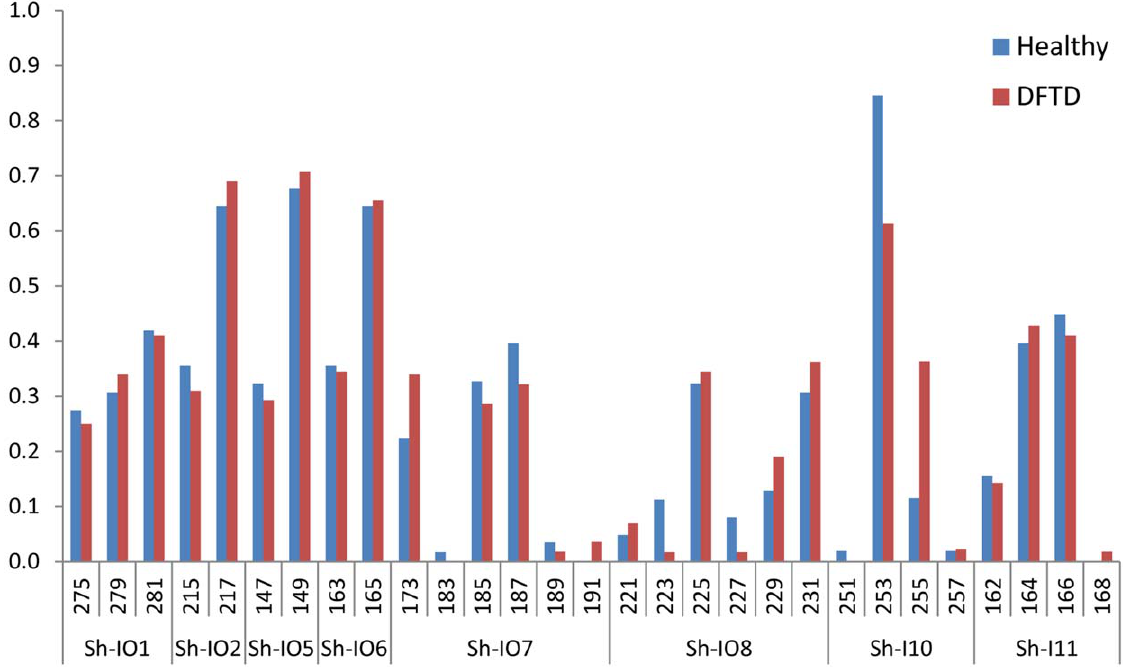
Figure 2. MHC-linked microsatellite loci allele frequencies showing little variation between healthy and DFTD infected devils. A single locus (Sh-I07) does not conform to Hardy-Weinberg expectations for healthy devils only (p=0.003). doi:10.1371/journal.pone.0036955.g002 PLoS ONE |